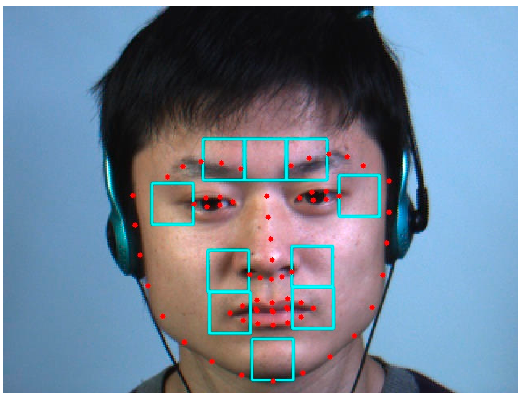
Figure 5. Regions of interest selection. The positions of the 68 facial landmarks are depicted in red circles and the 10 facial regions used to analyze the MEs are drawn with cyan rectangles (raw frames from CASME II database [12] (©Xiaolan Fu)).